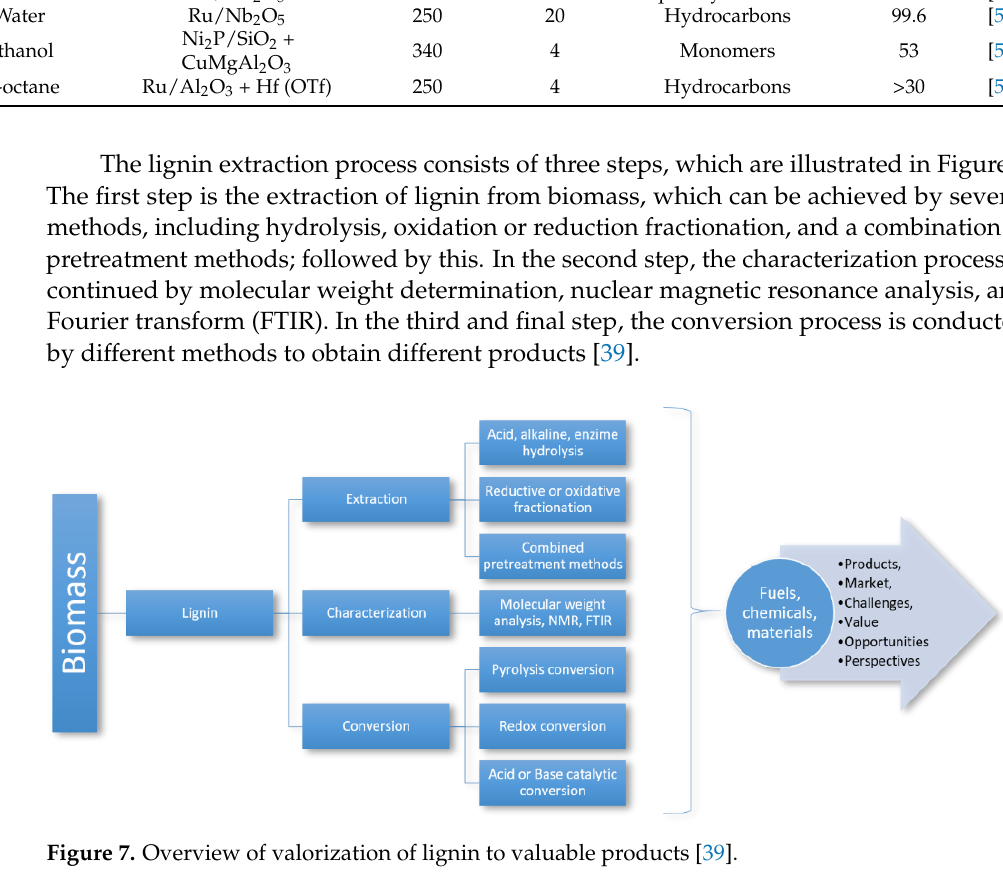
Table 2. Conversion of lignin in different solvents [43].